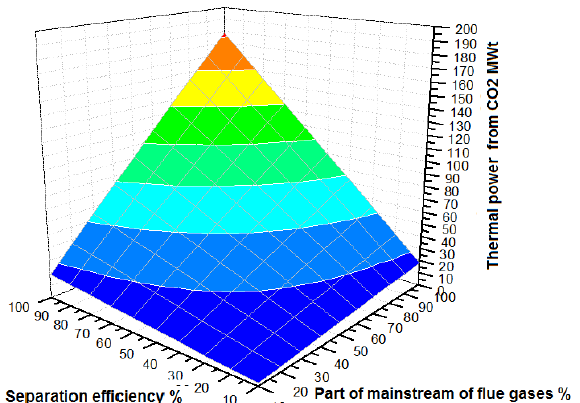
Fig. 2. Total heat output received from the CO 2 during its chilling. Table 2. Heat recovery from particular CO 2 chilling